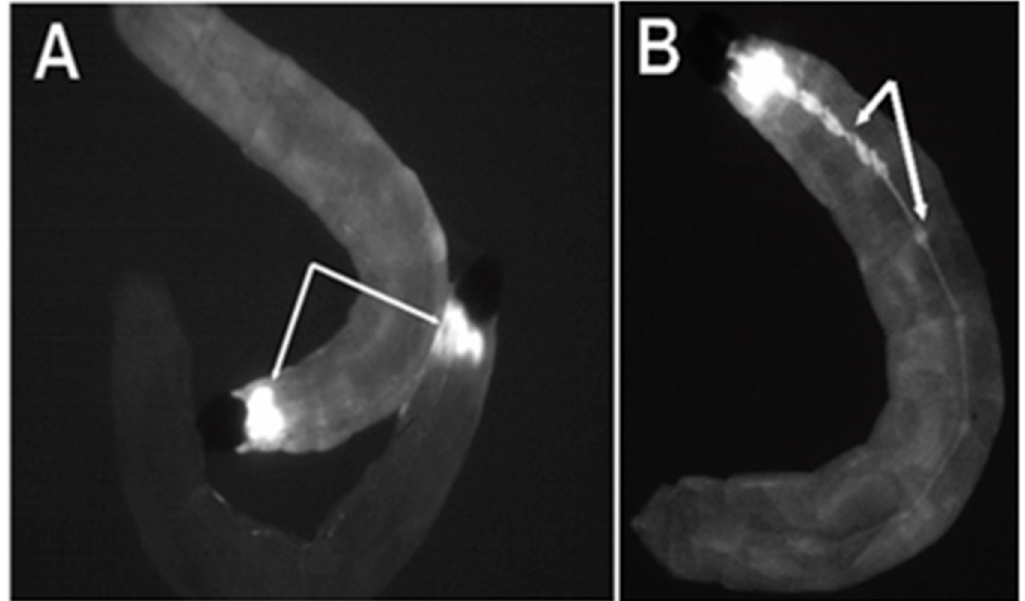
Figure 2. Expression of the ECFP fluorescent marker in flies transformed with pBac [3XP3-ECFPafm] attP-ZFN-T. Panels ( A , B ) are figures of third instar Bradysia ( Sciara) larvae from transformant lines T1 and T2. ( A ) Strong ECFP expression is observed in the larval brain (dorsal view). ( B ) Strong expression of ECFP is observed in the central ganglion along the length of the larval body (ventral view) in addition to signal in the brain (not visualized here since that is on the dorsal side).